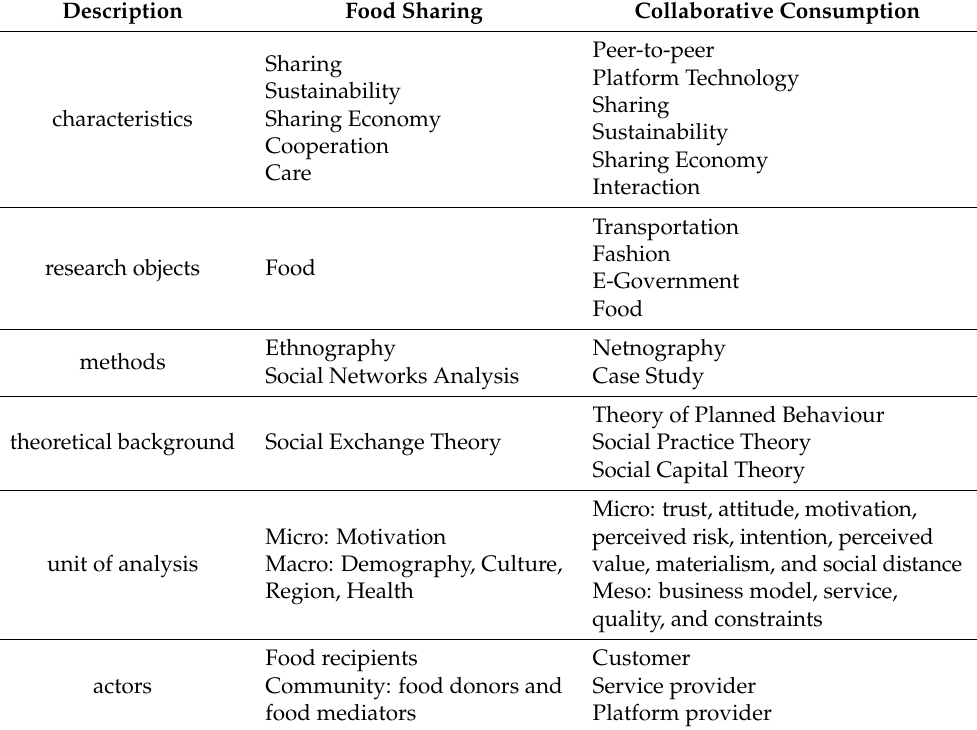
Table 2. The description of food sharing and collaborative consumption